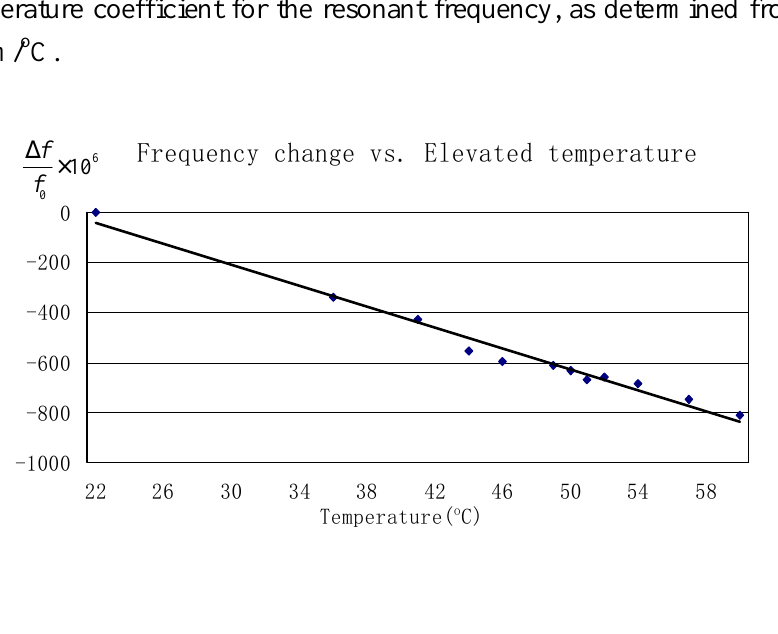
Figure 13. Normalized change in resonant frequency versus temperature for Device D